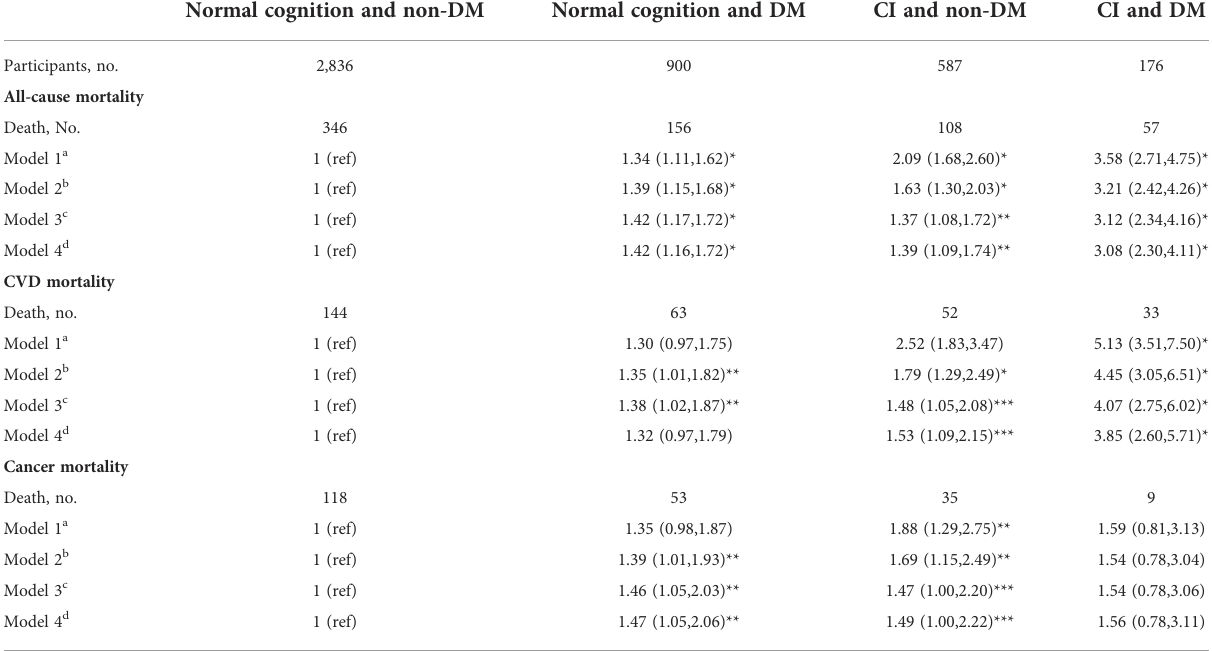
TABLE 2 Hazard ratios for the combined associations of DM and CI with all-cause and cause-speci fi c mortality. Normal cognition and non-DM Normal cognition and